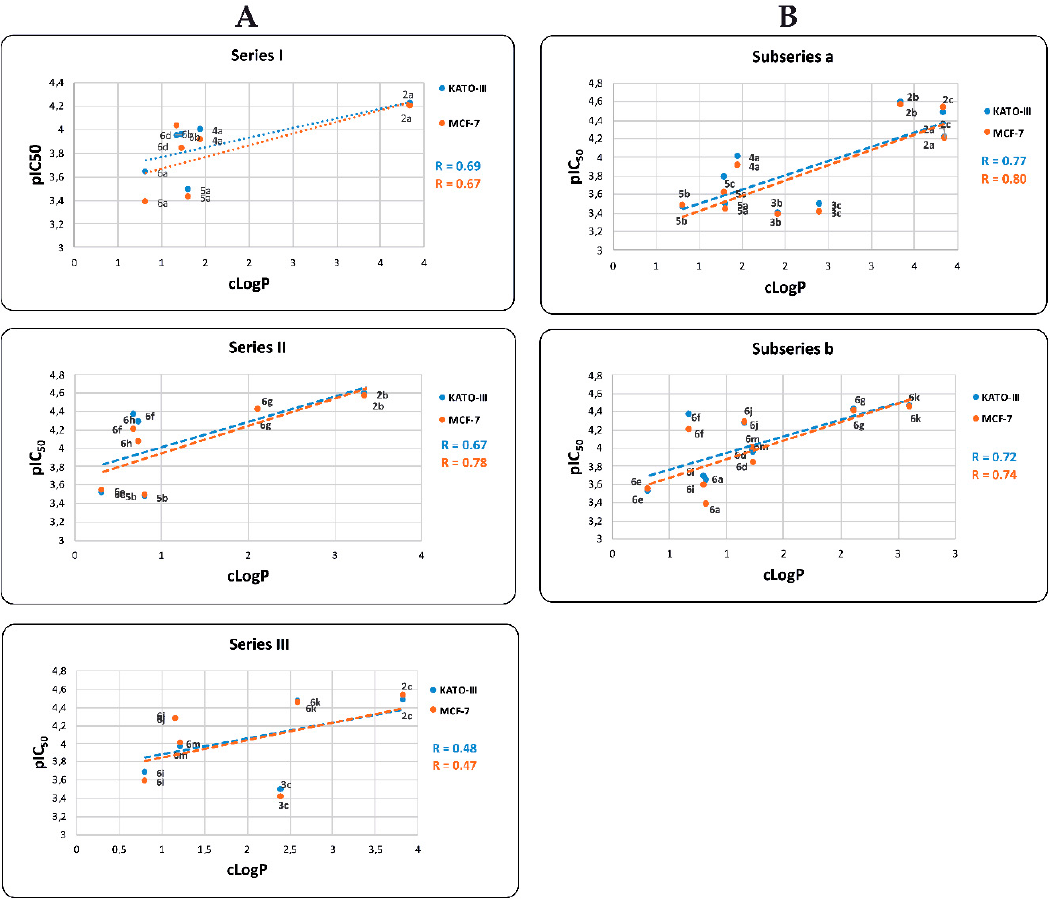
Figure 6. Relationship between pIC 50 and cLogP values for BIZQ derivatives of ( A ) Series I, II, and III and ( B ) subseries a and b . In this correlation analysis the same compounds as those considered in Figure 5 were taken into account.